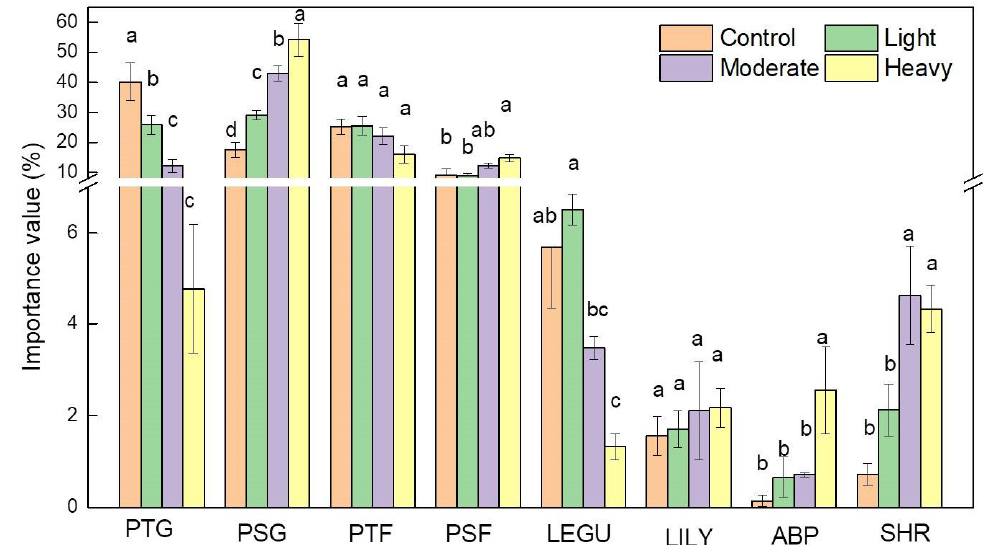
Figure 4. E ff ect of grazing intensity on plant functional groups: PTG—perennial tall grass; PSG—perennial short grass; PTF—perennial tall forbs; PSF—perennial short forbs; LEGU—legumes; LILY—Liliaceae herb; ABP—annual / biennial plant; SHR—shrub. Error bars indicate the standard error (SE) of the means ( p ≤ 0.05).